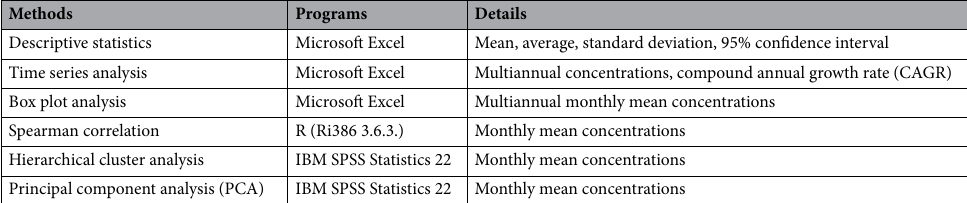
Table 1. Description of the statistical methods and programs used in this